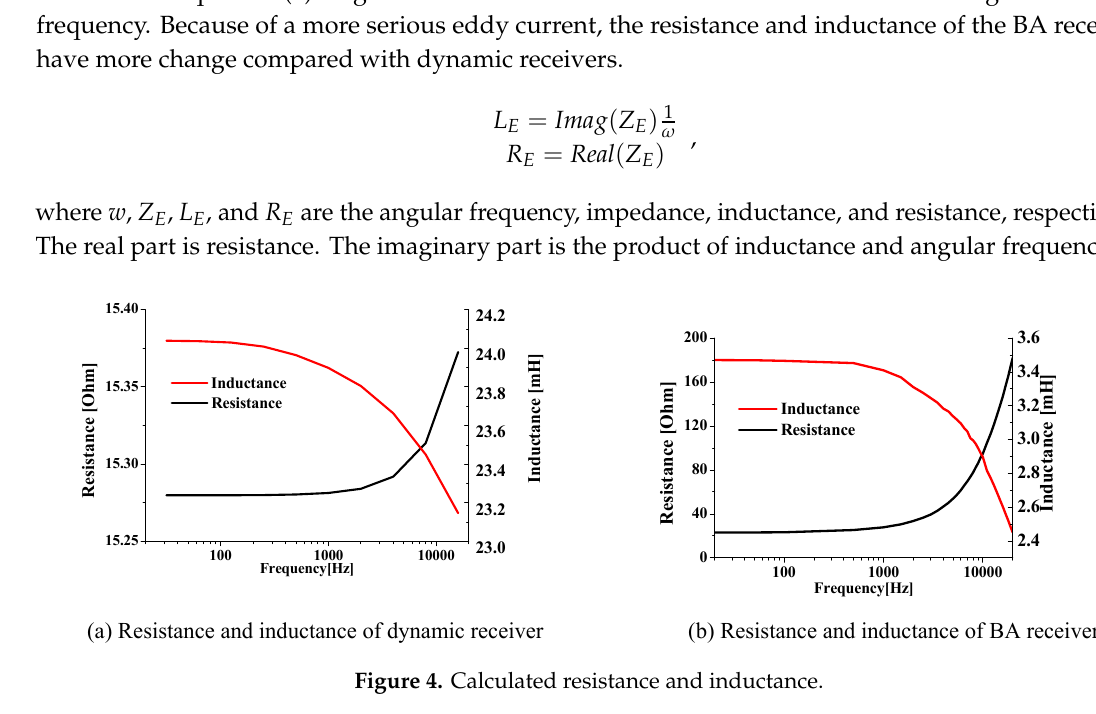
Figure 3. Electromagnetic domain boundary conditions.